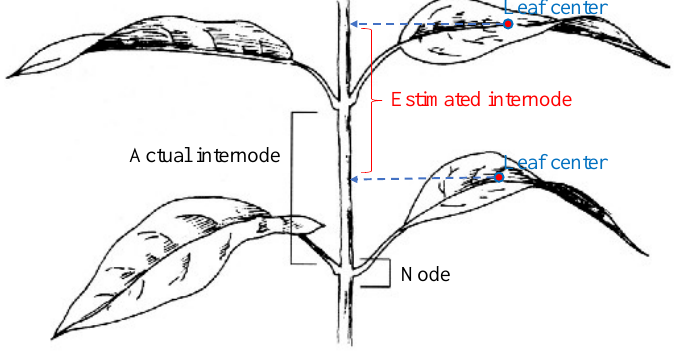
Figure 9. Illustration of internode distance estimation, where leaf centers are projected onto the plant’s principal axis. (The original internode image is from